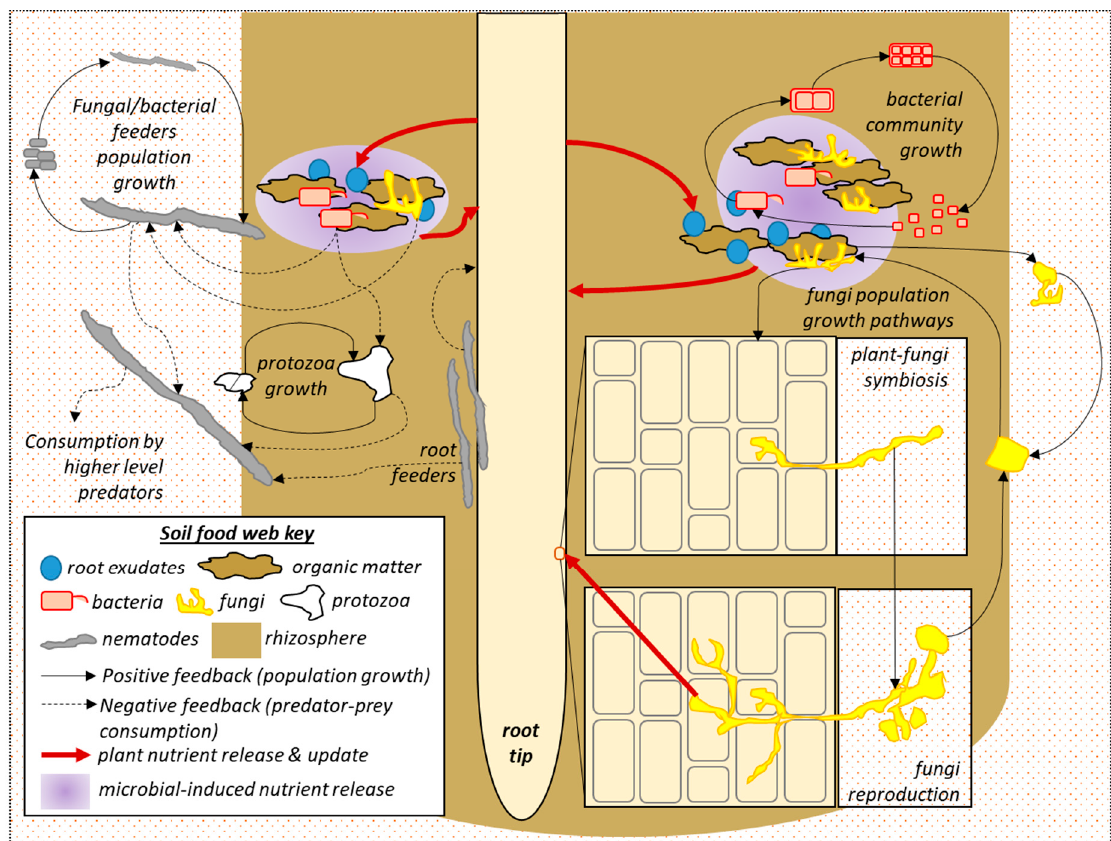
Figure 2. Schematic representation of several key rhizosphere feedback processes, including root exudation and nutrient uptake and soil food web reproduction and consumption.